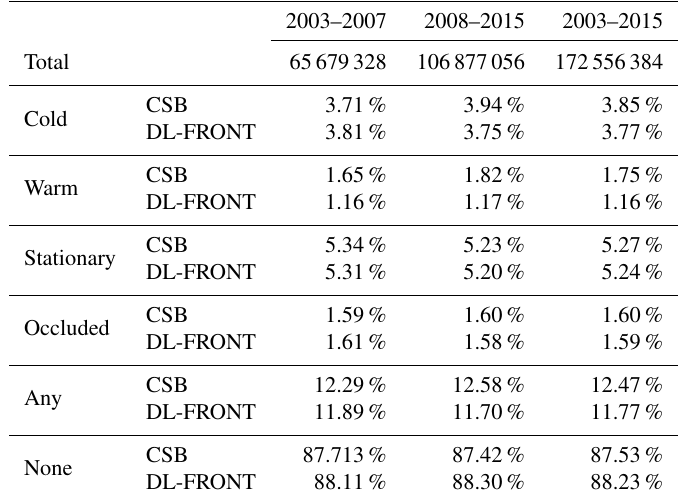
Table 1. Counts of CSB and DL-FRONT grid cells within the region mask over the training and validation time ranges and fraction of grid cells occupied by different front types.